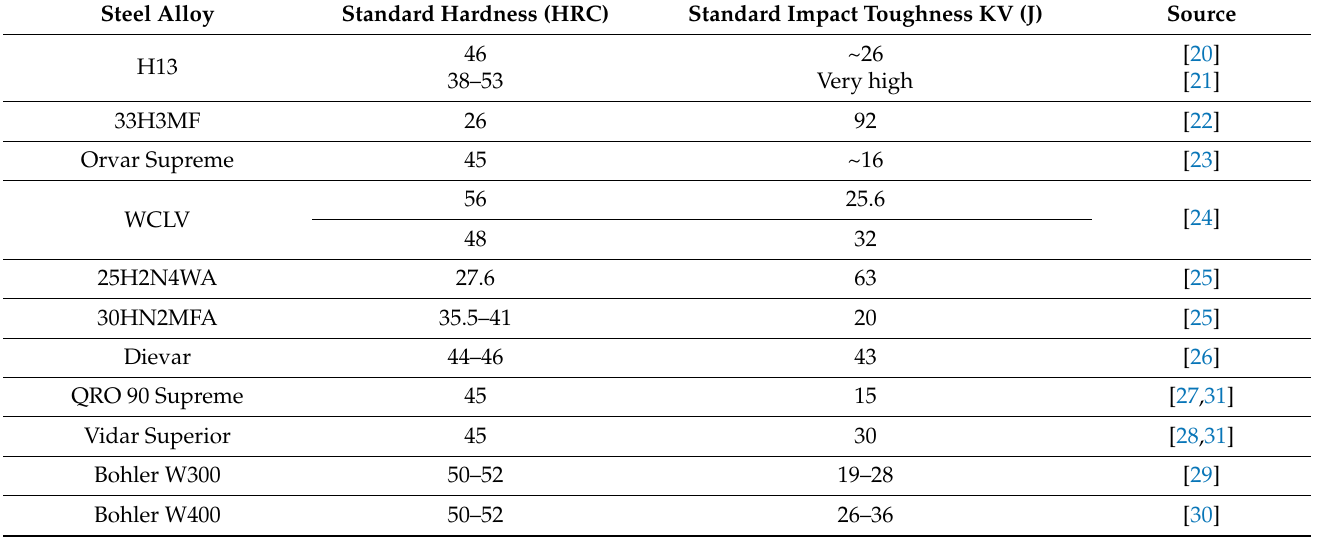
Table 4. Comparable hot work steels’ parameters.